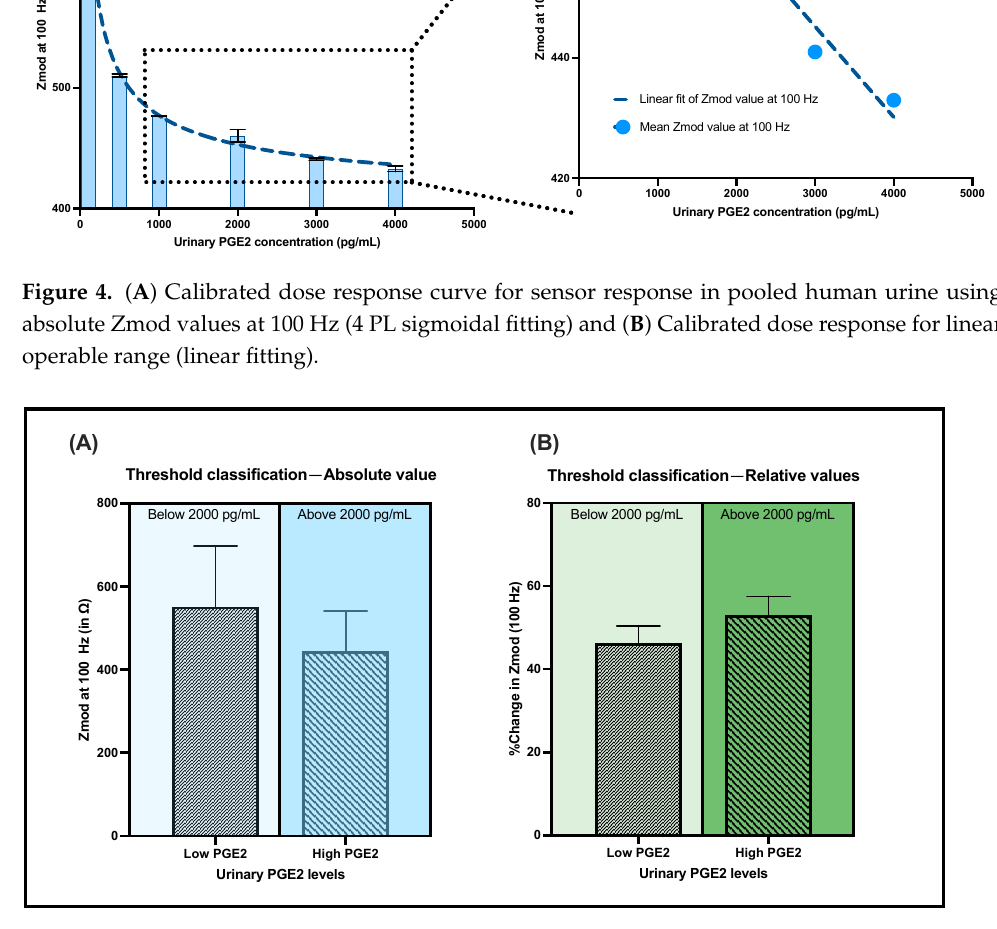
Figure 5. Threshold based UTI diagnosis using the developed sensor using EIS response for ( A ) ab- solute Zmod values at 100 Hz and ( B ) Zmod values relative to baseline dose.